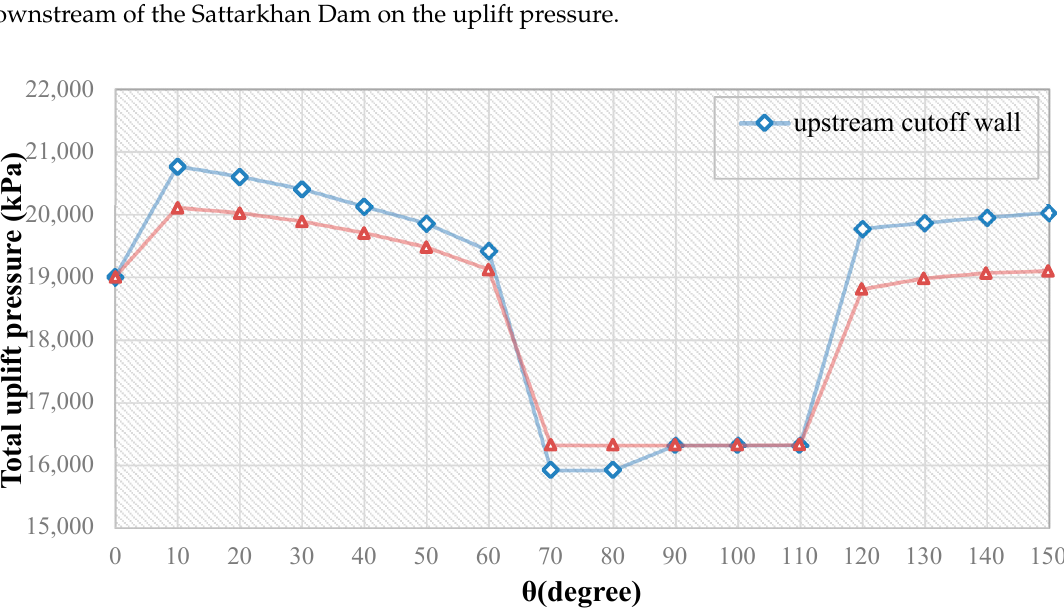
Figure 8. Uplift pressure for the dam in the case of one curtain on upstream and downstream with angle.